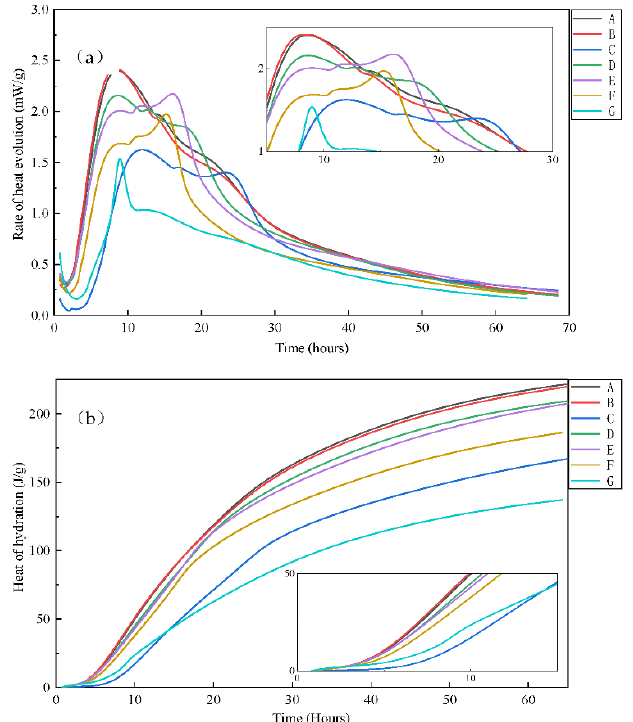
Figure 1. Influence of mineral admixtures on hydration heat. ( a ) Rate of heat evolution; ( b ) cumulative heat of hydration.